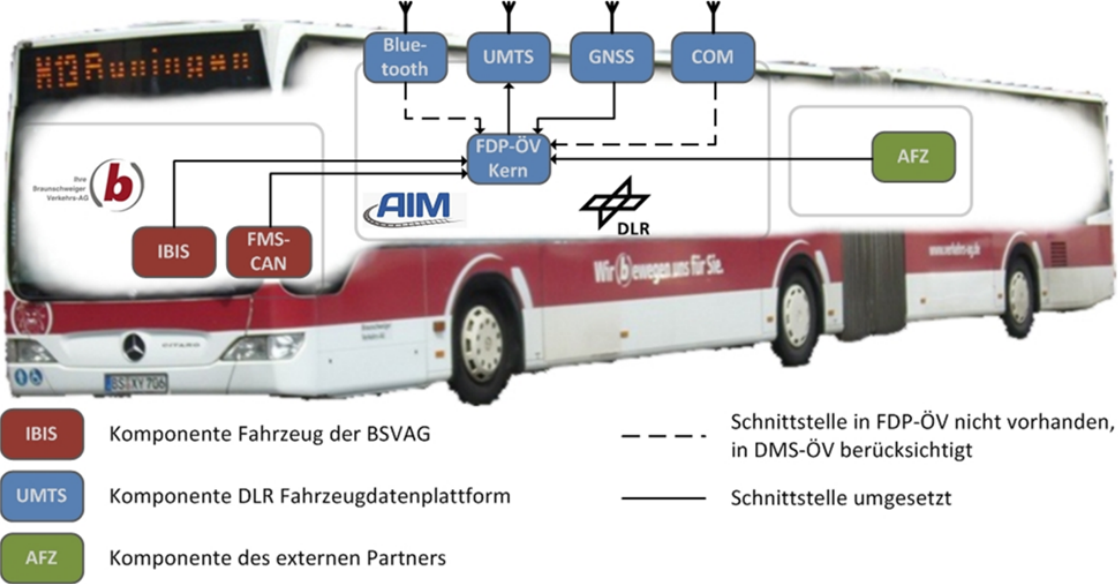
Figure 5: Architecture of the public transport data framework, status in